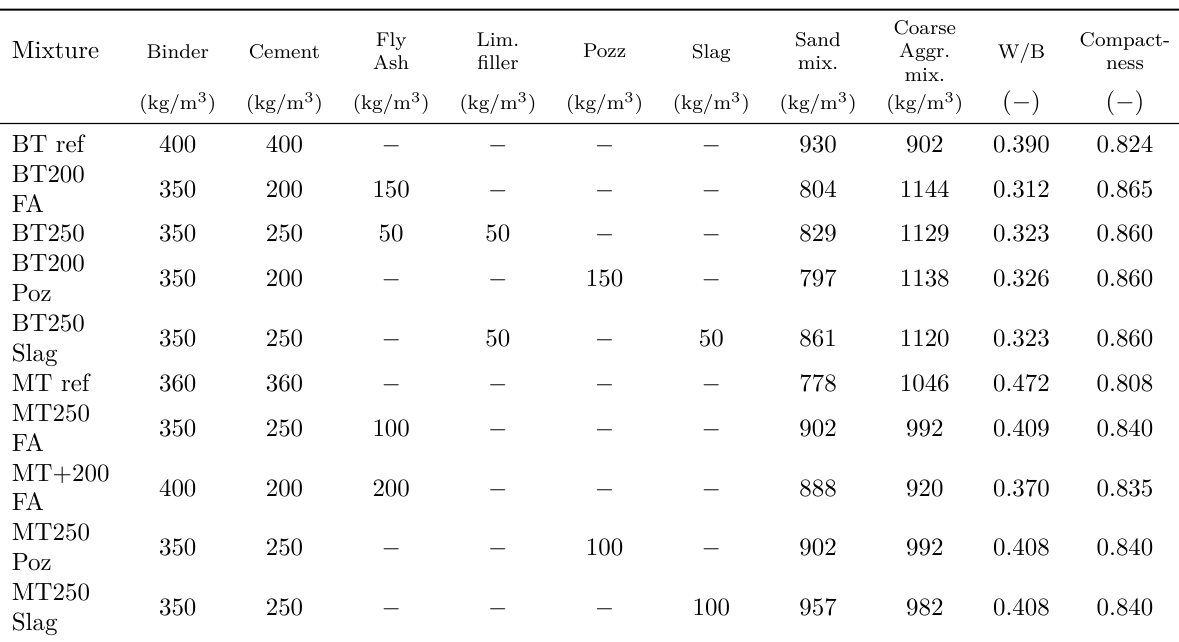
Table 1. Formulation of concrete mixtures used to produce the mortar